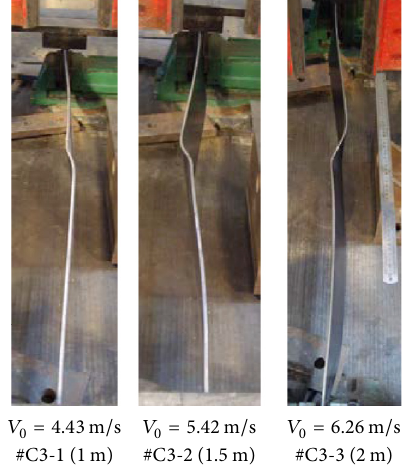
Figure 12: Deformation modes of #C1 (𝛼 = 20, 𝛽 = 10) .